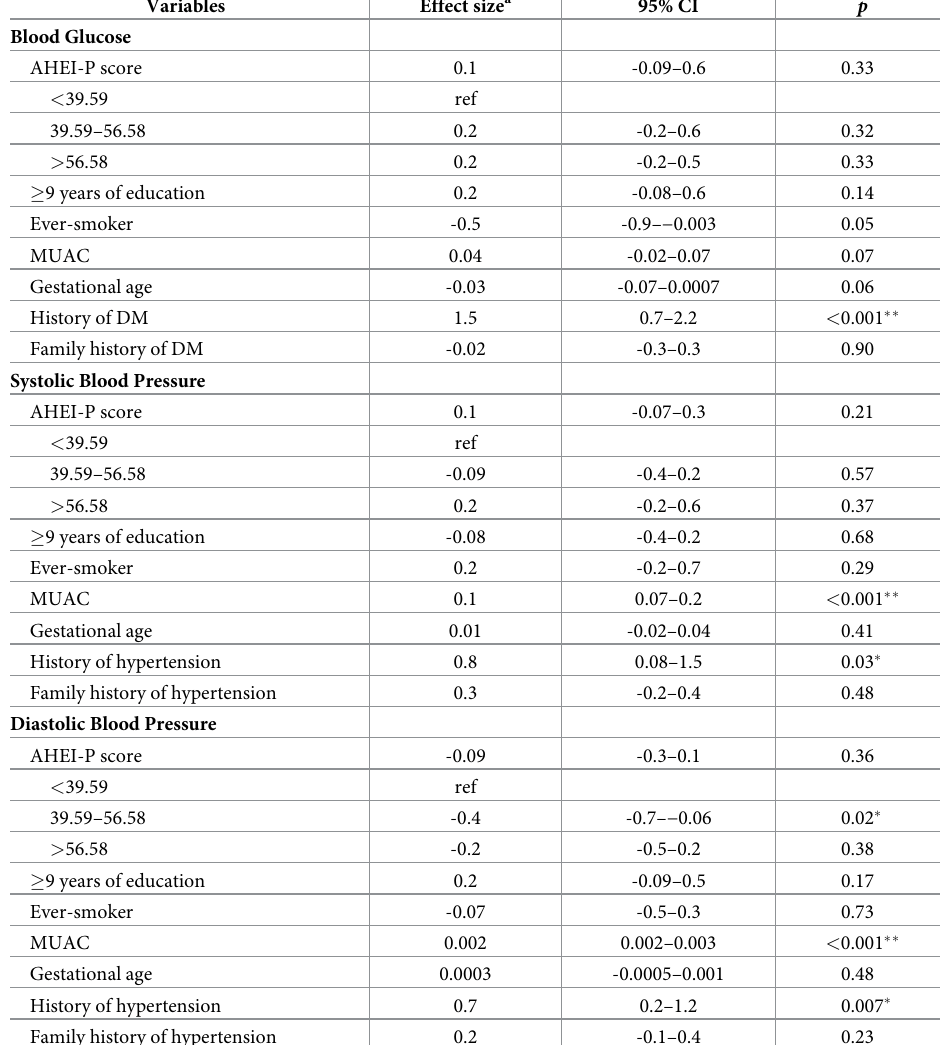
Table 5. Multiple linear regression of diet quality with blood glucose and blood pressure among pregnant women in Jakarta (n = 174).